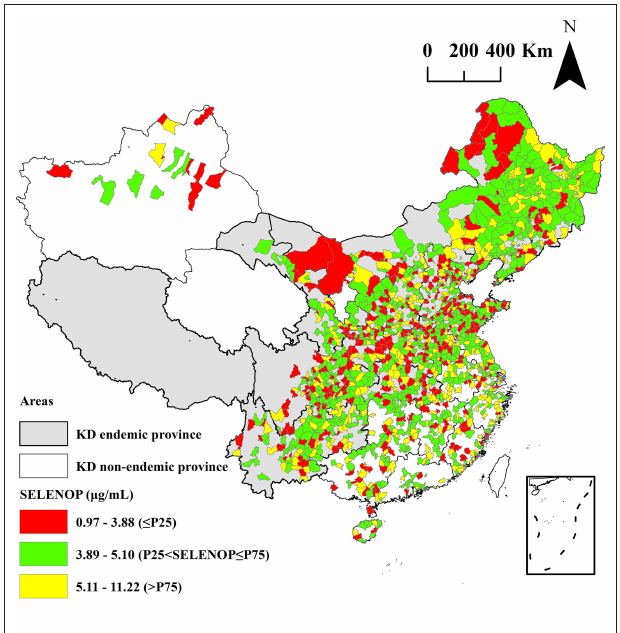
FIGURE 2 | Spatial distribution of the mean serum SELENOP levels at the